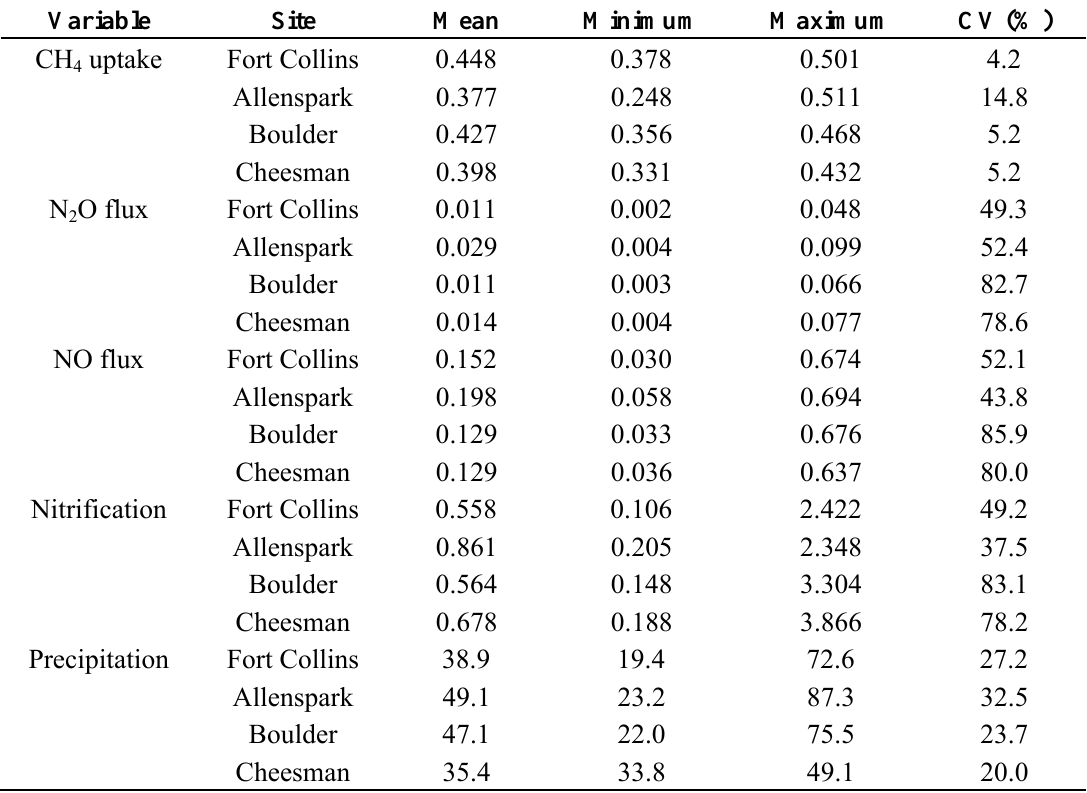
Table 6. Mean, minimum, maximum and CV (%) for CH nitrification rates and annual precipitation (cm). Mean, maximum and minimum values for fluxes and nitrification are given as g·m − 2 ·yr − 1 . These descriptive data are derived from the years